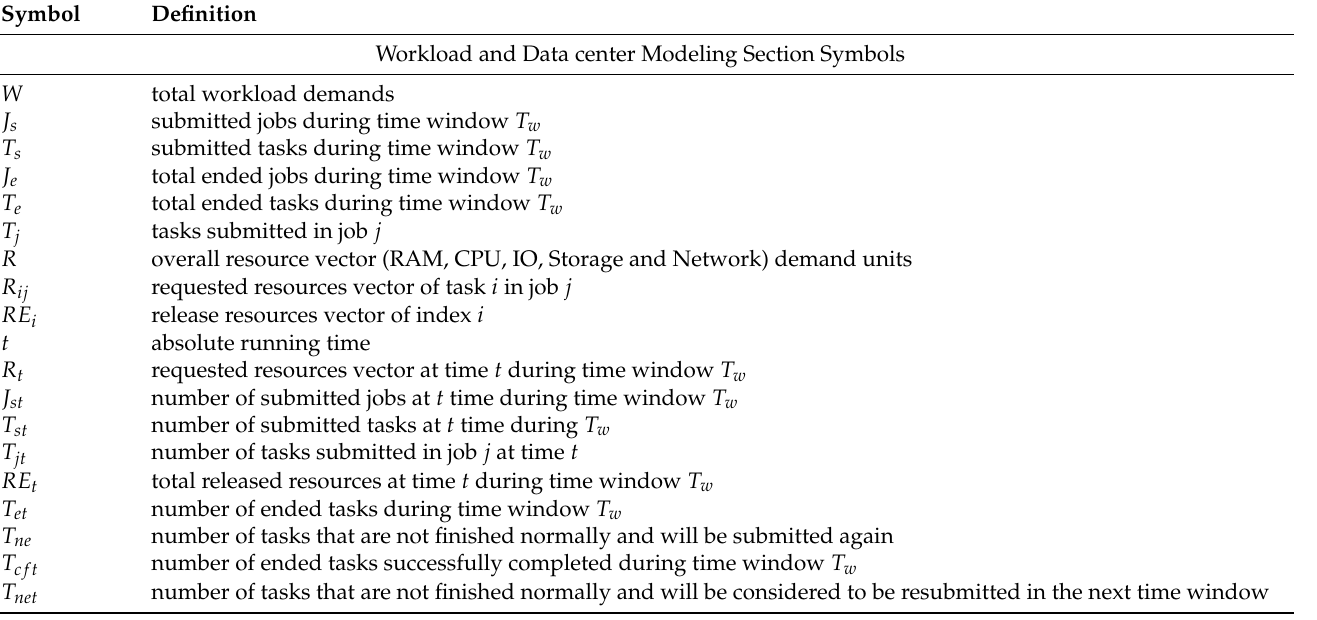
Table 2. Key Symbols Used in the Analysis and their